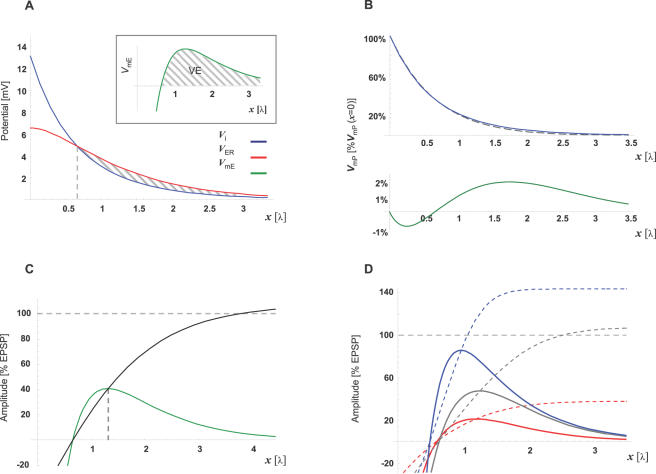
The CIC system predicts a Virtual-Electrode along the ER membrane under realistic parameters.Steady-state description of the CIC-model prediction under the parameters described in Table 2. (A) The potential along the cytosol (blue; V
i) and the potential along the ER lumen (red; V
ER) decay at different rates along distance (x[λ]) given in electrotonic units. As a result, the ER transmembrane potential (green; V
mE, given by the difference between V
ER and V
i) generates a qualitatively unique pattern (inset). Namely, V
mE is negative along ∼0.65 space-constants from the synapse, where it crosses the zero line, becomes positive and then decays to zero V
mE. We name the positive segment (where V
mE>0) that follows a negative segment (where 0<V
mE), ‘Virtual-Electrode’ (VE; Dashed area, see text for details). Note that practically V
mP = V
i (solid red line), since we assume that V
e→0. (B) Comparison between the prediction of the CIC model (solid line) and the prediction of the conventional cable model (dashed line) for the transmembrane potential along the plasma membrane (V
mP). Both traces were normalized to V
mP at the synapse (V
mP(x = 0)). Bottom: Subtracting the prediction of the conventional cable model from the prediction of the CIC model (green line). Note that the maximal difference between the two predictions lies below 2% of V
mP(x = 0). (C) The spatial pattern of the peak potential across the ER membrane (VE-peak) is compared to the EPSP amplitude at the same distance from the synapse (nVE; green) and shows that at the peak, the VE reaches ∼41% of the EPSP. A second way to compare the V
mE to the EPSP is presenting V
mE as a fraction of V
mP at each point along the cable. (black line) This representation of V
mE shows that at positions beyond the peak of the VE, the V
mE amplitude reaches values greater than the V
mP amplitude. (D) Parameter dependency of VE amplitude and pattern: V
mE was recalculated after increasing (blue) or decreasing (red) N or E (the non-conductive cross-section or the ER cross-section, respectively) by 15% from the default parameters (gray) provided in Table 2. V
mE is presented in relation to EPSP as nVE representation and as a fraction of V
mP at each point along the cable (solid lines and dashed lines, respectively).